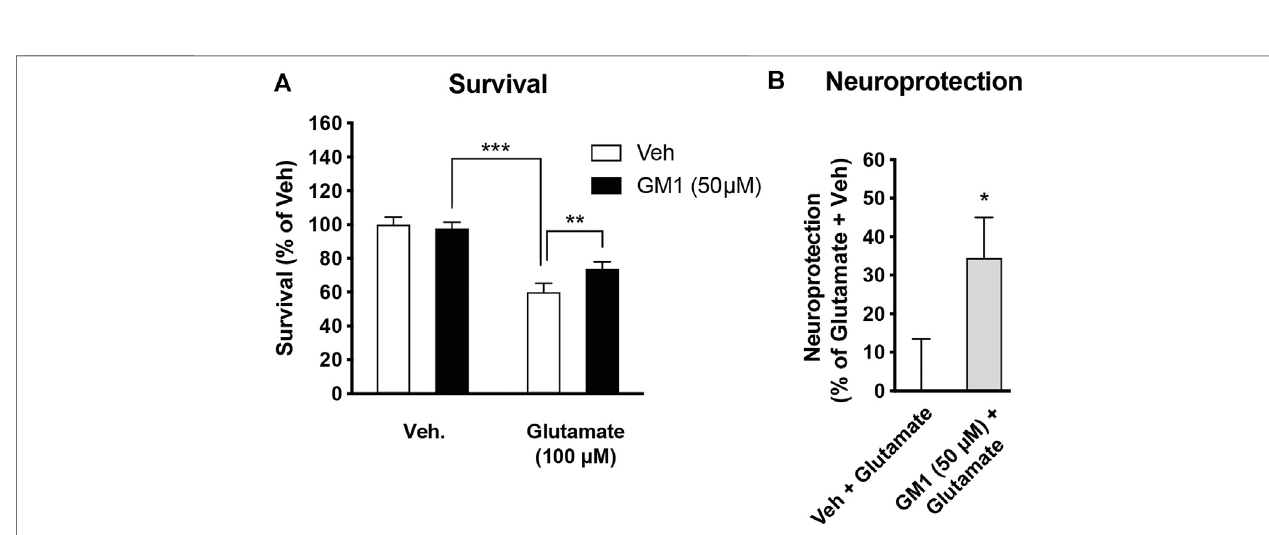
FIGURE 6 | Neuroprotective effect of GM1 in astrocyte-neuron co-cultures. (A) Survival of neurons in astrocyte-neuron co-cultures was measured by MTT after exposure to medium (- glutamate) or glutamate (100 μ M) for 10 min. Veh (0.1% DMSO) or GM1 (50 μ M) was present in the medium 2 h before and 4 h after glutamate exposure, and MTT was used in neurons to monitor mitochondrial function and evaluate their survival. (B) Neuroprotective effect of GM1 was calculated as the percent (%) ofneuroprotective effect ofVeh (0.1% DMSO) vs. GM1 (50 μ M); values of 0% (baseline) and 100% correspond to treatment without glutamate (+Veh) and with glutamate(+Veh),respectively.Dataareshownastheaverage+SEMofMTTlevelsandrepresentedas%ofcontrolvalues( n (cid:2) 12).Statisticalanalysesconsistedinone- way ANOVA followed by Bonferroni ’ s post-hoc test (A) or unpaired bilateral Student ’ s t test (B) ; * p < 0.05, ** p < 0.01, *** p < 0.001.